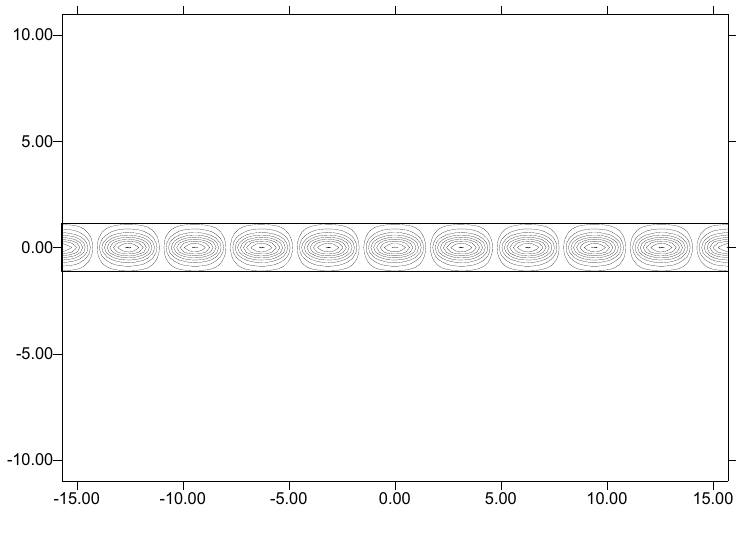
Figure 3. Streamlines of the finite-wavelength regime.